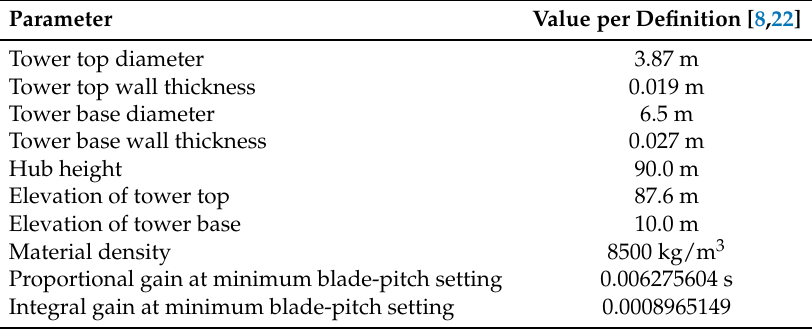
Table 3. Properties of the wind turbine for the OC3 floating system.